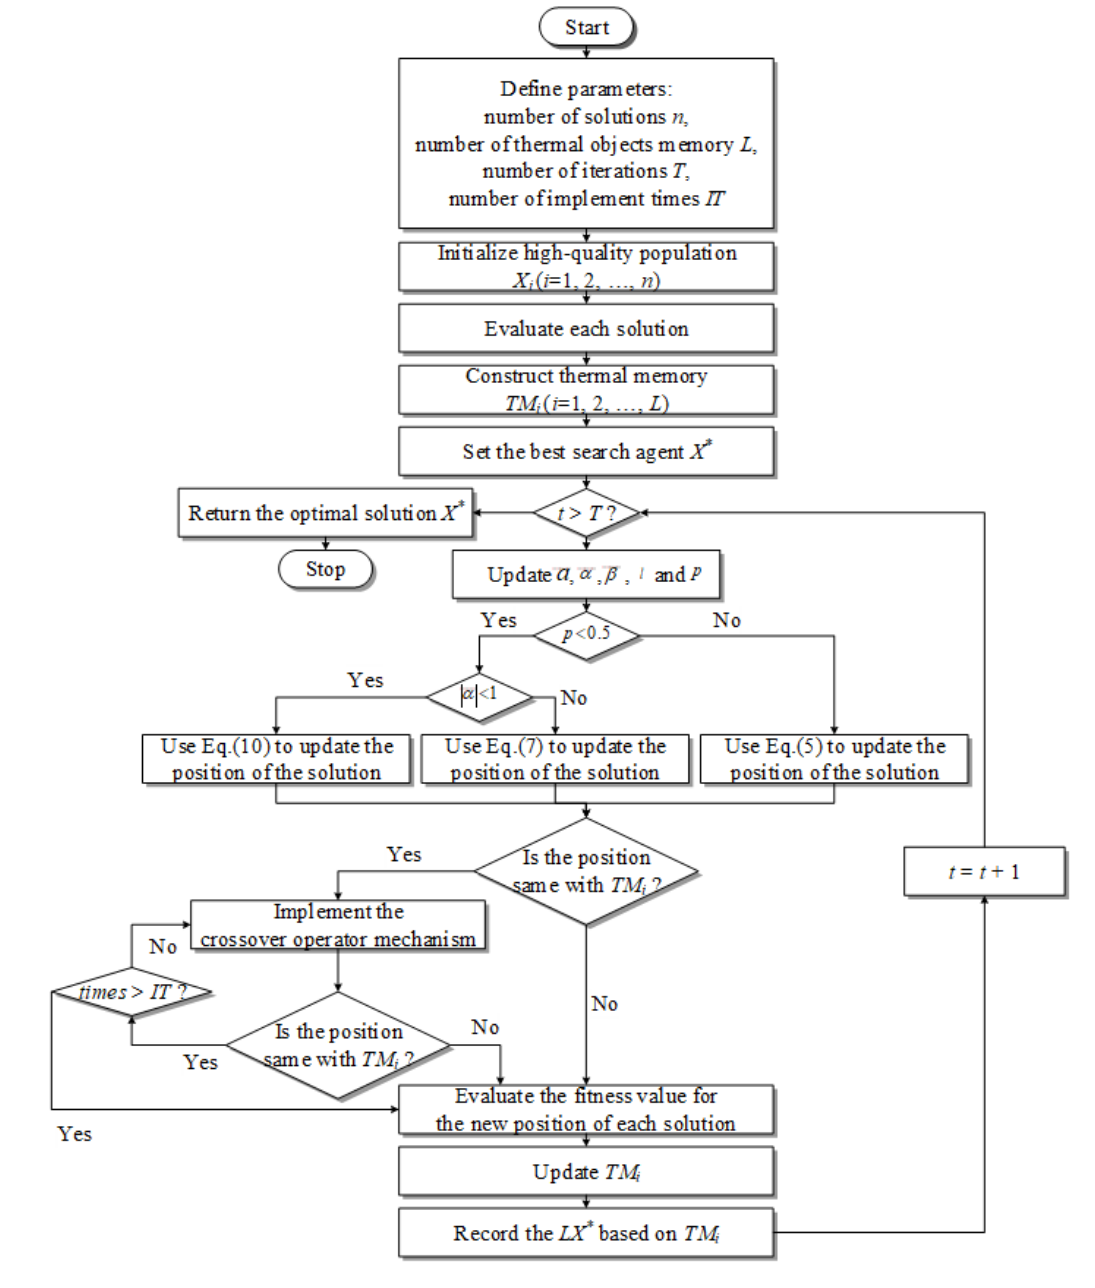
Figure 4. The flowchart of the proposed